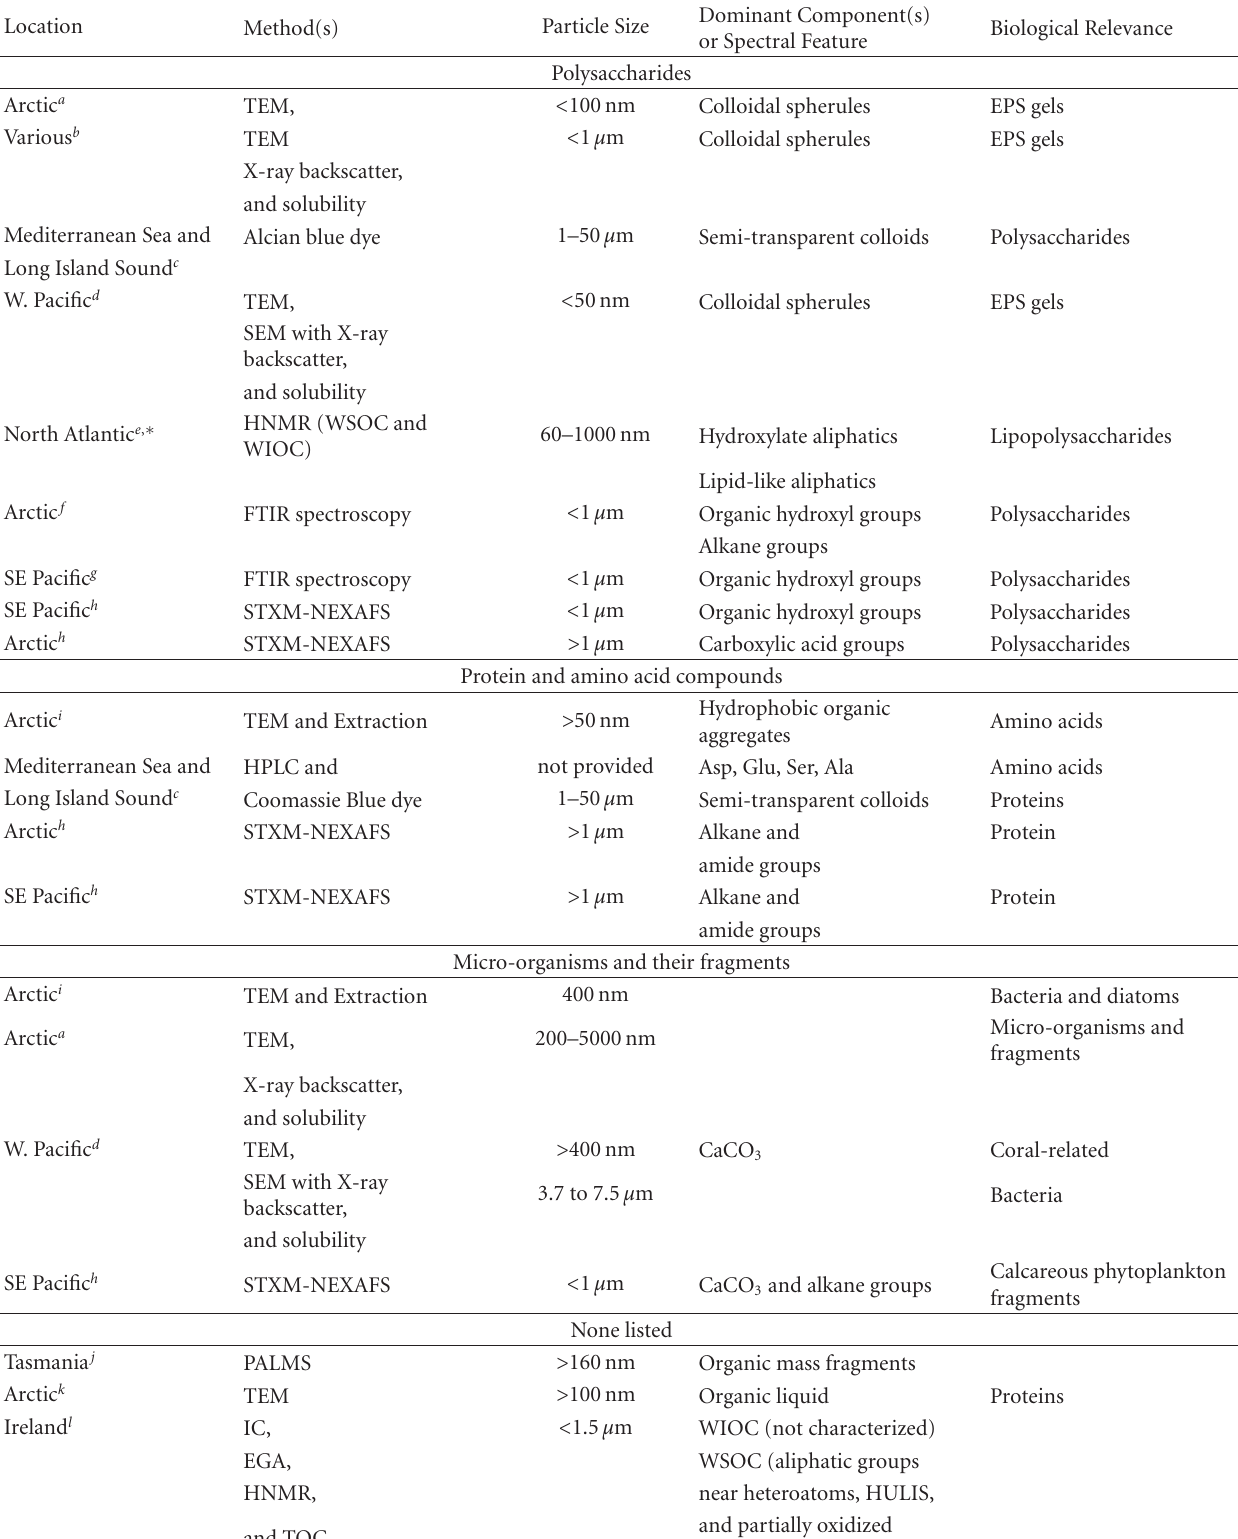
Table 3: Observed types of marine primary organic aerosol and the suggested biological relevance of specific particle